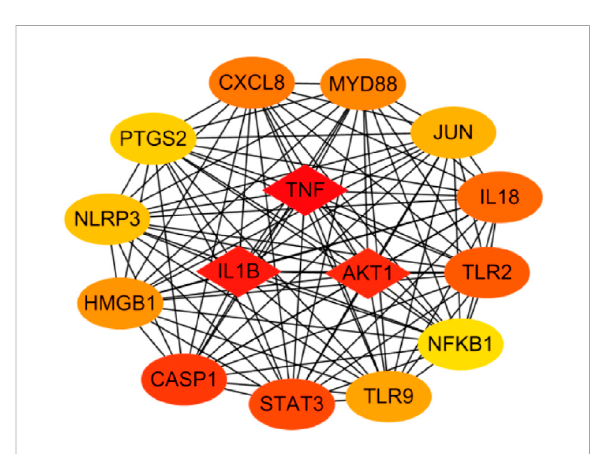
FIGURE 6 The top 15 hub genes. The network of the top 15 hub genes by